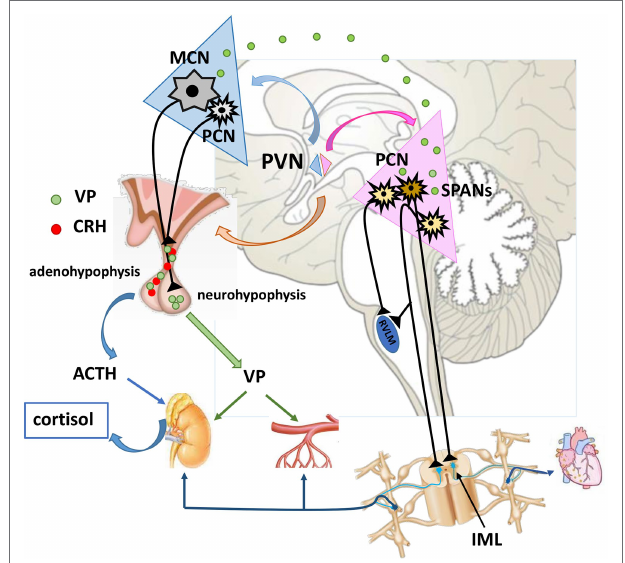
FIGURE 1 | Neuroendocrine and pre-autonomic paraventricular nucleus in cardiovascular regulation. MCNs synthetize VP which is transported via their axons to neurohypophysis for systemic release. Once in the circulation, VP reaches distant targets (kidneys, resistance vessels) to exert its effects. Some portion of VP is released intranuclearly, and modulates the activity of pre-autonomic PCNs. These pre-autonomic neurons have the potential to modulate the autonomic outflow toward heart, kidneys and arterioles. Additionally, VP is co-expressed with CRH alternating the reactivity of HPA axis. VP, vasopressin; CRH, corticotropin-releasing hormone; ACTH, adrenocorticotropic hormone; MCN, Magnocellular neuron; PCNs, parvocellular neuron; SPANs, spinally projecting pre-autonimic neurons; RVLM, rostral ventrolateral medulla; IML, intermediolateral